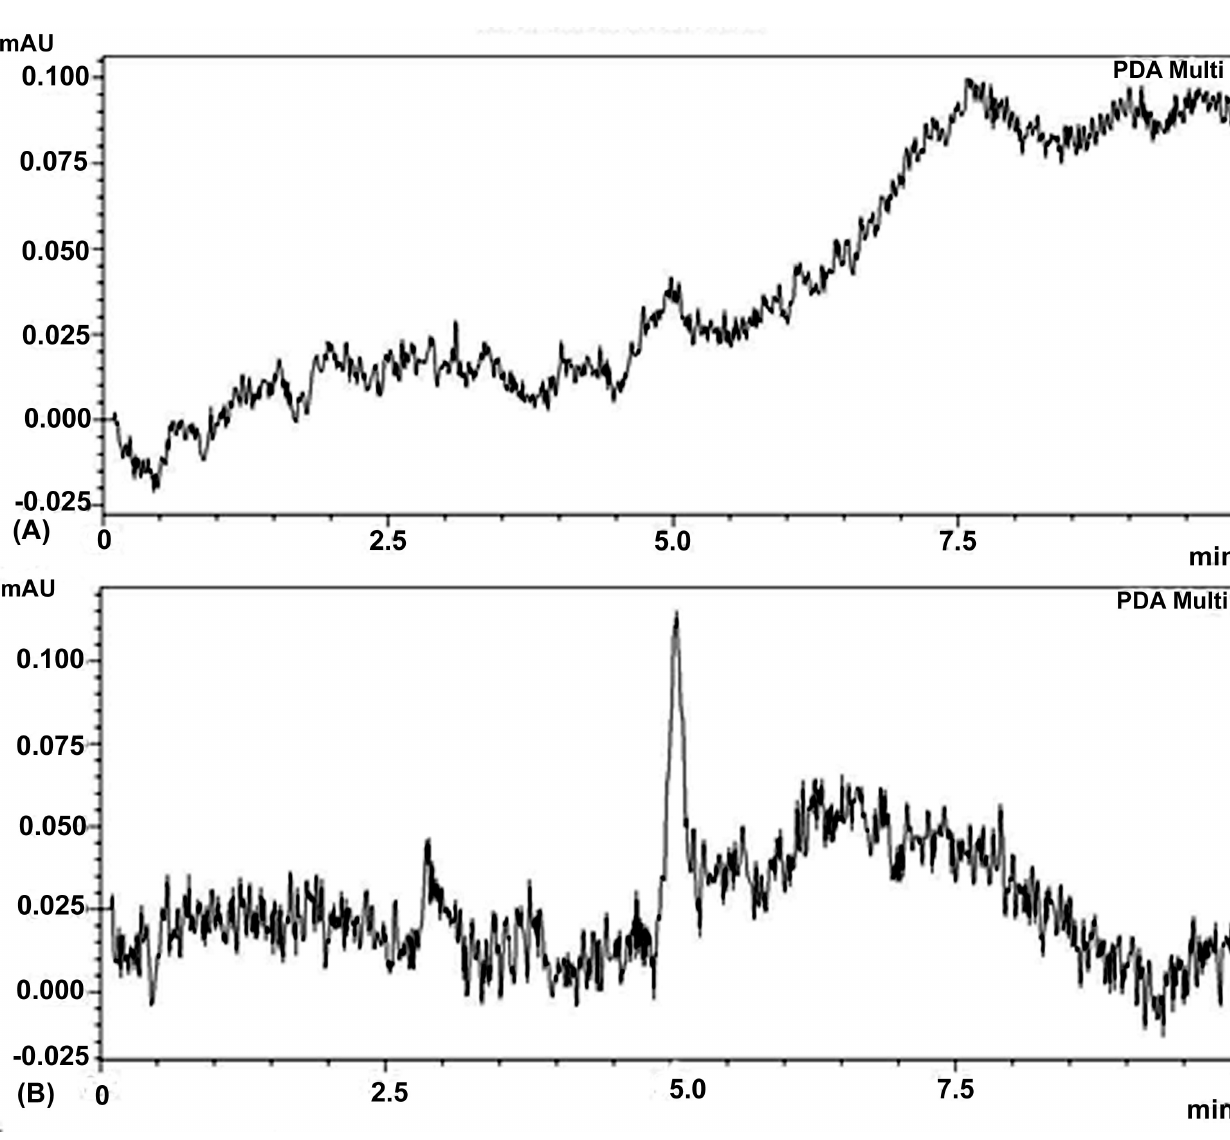
FIGURE 5 - Typical chromatograms depicting non-interference of formulation components at analytes retention time when blank mobile phase was injected with (A) hydrochloric acid and sodium hydroxide mixed solution, (B) benzyl alcohol